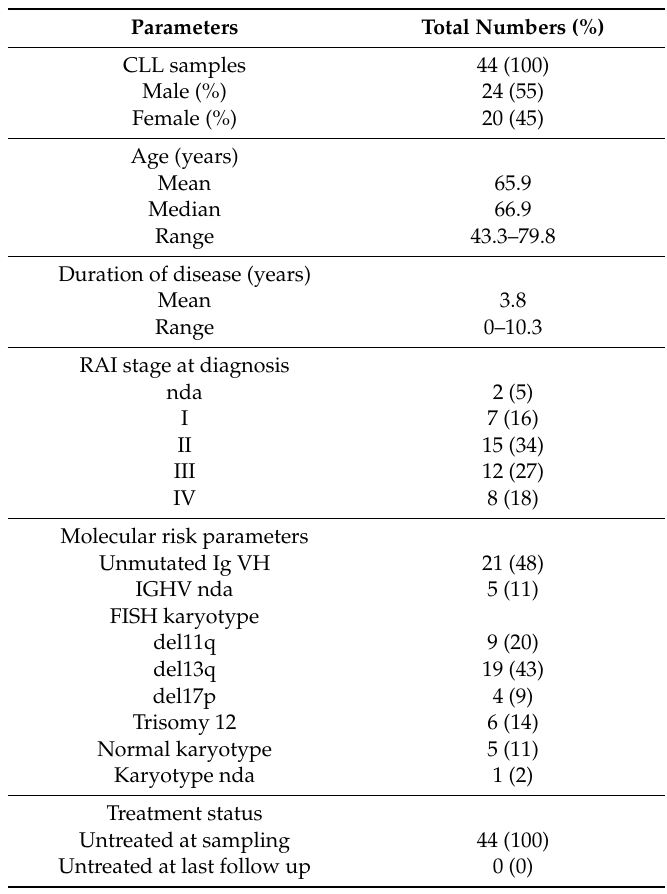
Table 1. Patient